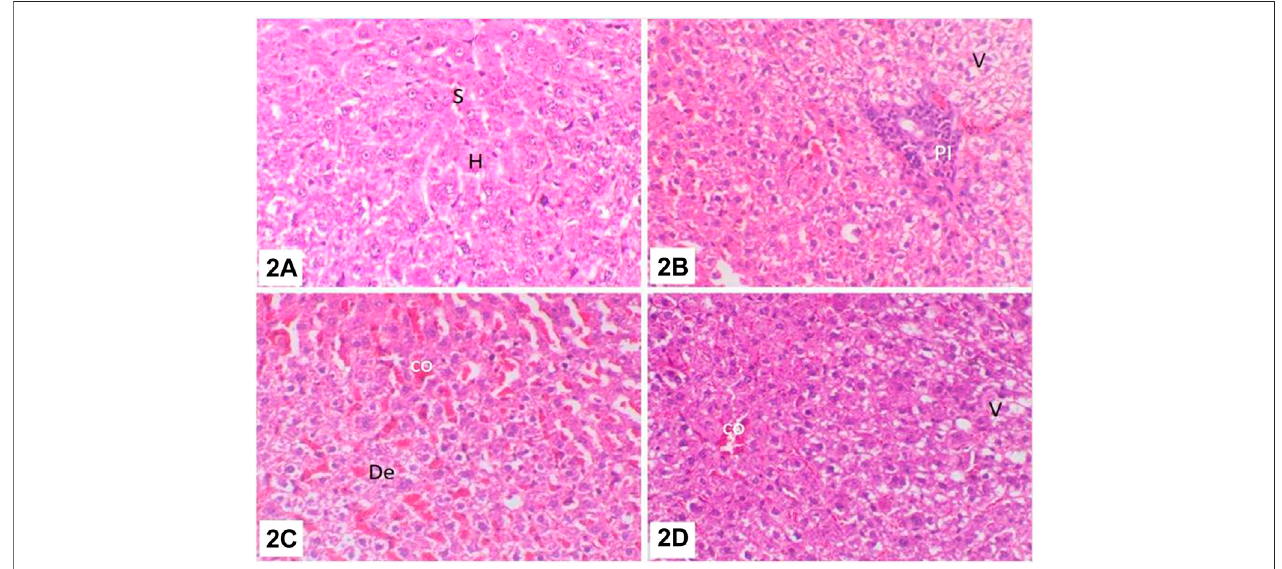
FIGURE 7 | (A) Liver of control untreated rats: hepatic sinusoid (S) and hepatocytes (H); (B) liver of rats treated with water contaminated with dimethoate after remediation with ZnO(s)/H